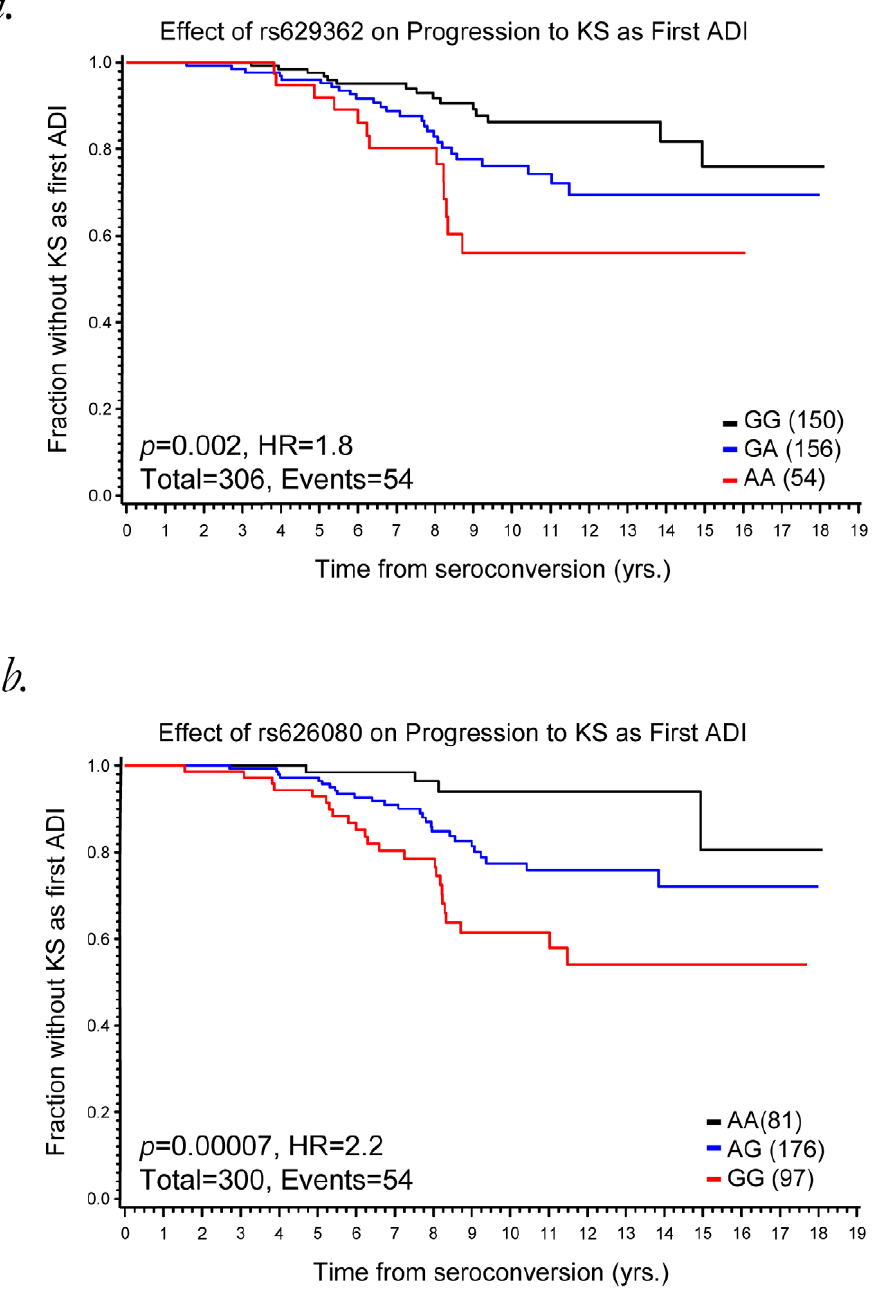
Figure 3. The effect of rs629362 (a) and rs626080 (b) in PECI on progression to AIDS-defining illness (ADI) Kaposi Sarcoma (KS). doi:10.1371/journal.pone.0012862.g003 PLoS ONE |